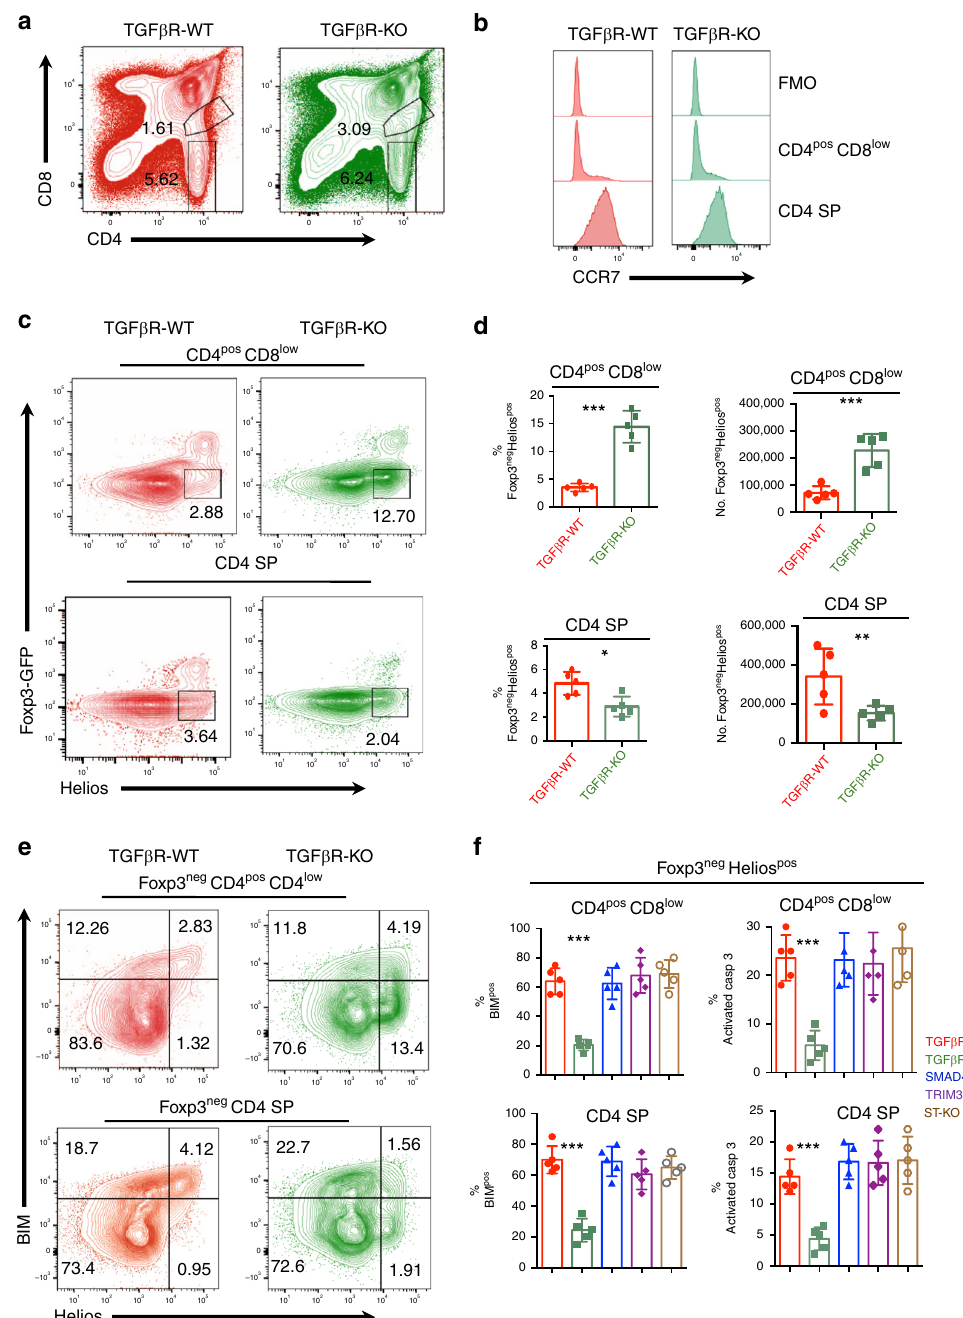
Fig. 1 TGF- β signaling in thymocytes promotes cortical and medullary negative selection. Flow cytometry analysis was performed on thymus from TGF β R- KO mice, SMAD4-KO mice, TRIM33-KO mice, ST-KO mice and their wild-type littermate controls. a , b Gating strategy for fl ow cytometry analysis of CD4 pos CD8 low and CD4 SP thymocytes. c Representative contour plot analysis of the expression of Foxp3 and Helios among the CD4 pos CD8 low and CD4 SP thymocytes. d Graphs illustrate the proportion of Foxp3 neg Helios pos among CD4 pos CD8 low and CD4 SP thymocytes as well as their absolute numbers. e Representative contour plot analysis of the expression of BIM and Helios in Foxp3 neg CD4 pos CD8 low thymocytes and in Foxp3 neg CD4 SP thymocytes. f Graphs illustrate the percentages of cells expressing BIM and positive for activated caspase 3 among Foxp3 neg Helios CD4 pos CD8 low thymocytes and in Foxp3 neg Helios pos CD4 SP thymocytes. All the experiments were conducted in 7 – 10-day-old animals. Data are representative of three experiments with 3 – 5 mice per group. * P <0.05, ** P <0.01, *** P <0.001 (two-tailed Student ’ s t test). Error bar, mean±SEM. Source data are provided as a Source Data fi le.